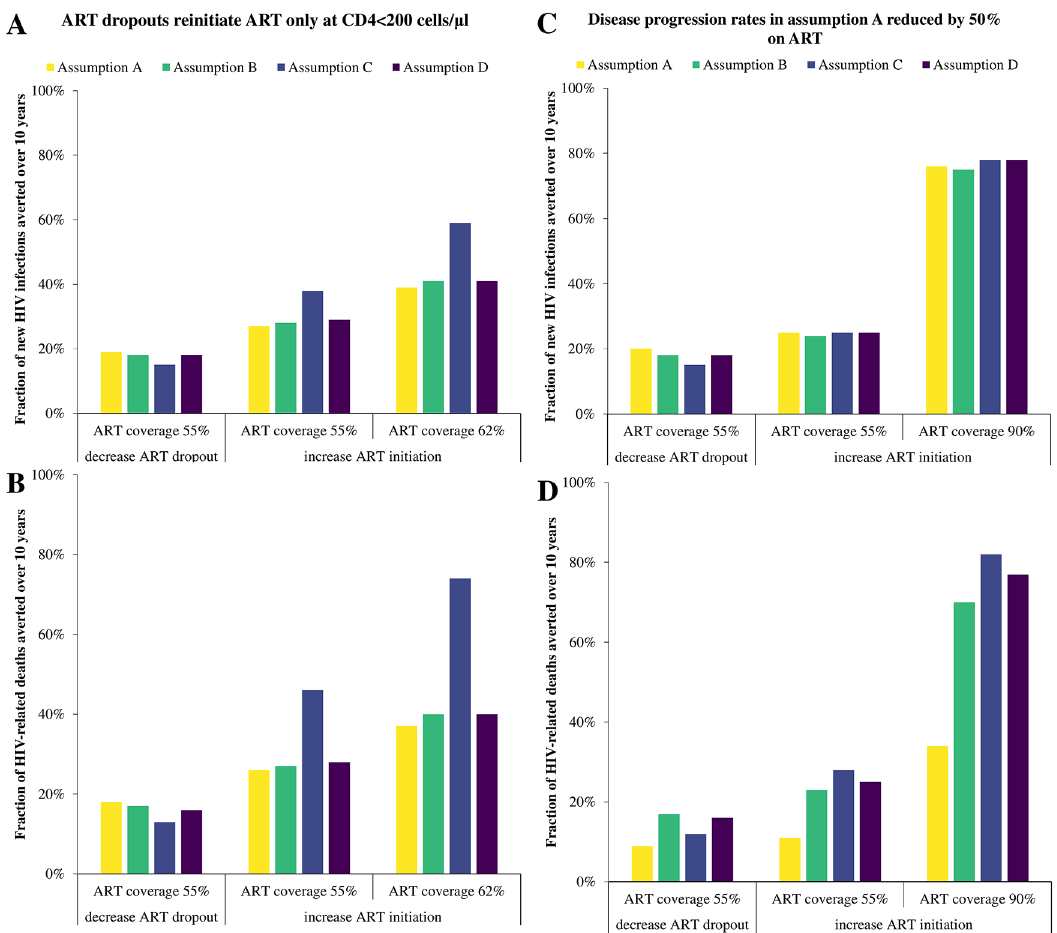
Fig 4. Sensitivity analysis—ART dropouts reinitiate ART only at CD4 < 200 cells/ μ l.A) The fraction of HIV infections averted and B) The fraction of HIV-related deaths averted over the 10 year period when ART initiation rate is increased or ART dropout rate is decreased to achieve a final ART coverage of 55% or 62%. HIV-attributable mortality and disease progression rates in assumption A reduced by 50% on ART vs. off ART instead of 90%: C) The fraction of HIV infections averted and D) The fraction of HIV-related deaths averted over the 10 year period when ART initiation rate is increased or ART dropout rate is decreased to achieve a final ART coverage of 55% or 90%.